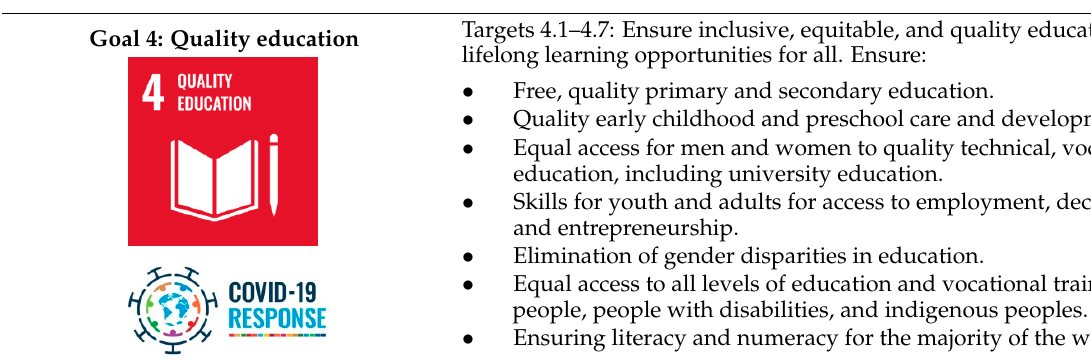
Table 5. Impact of the Sustainable Development Goals on IoT applications for improving health and the environment. SDGs Targets Goals and Application to IoT